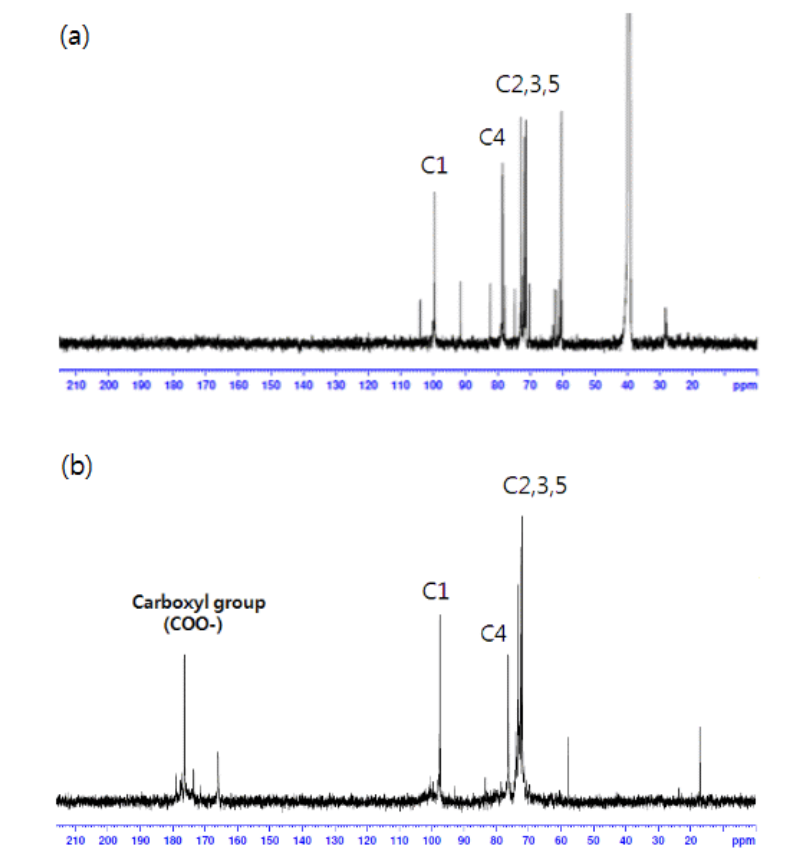
Figure 1. 13 C-NMR spectra of original cellulose ( a ) and carboxylated cellulose ( b